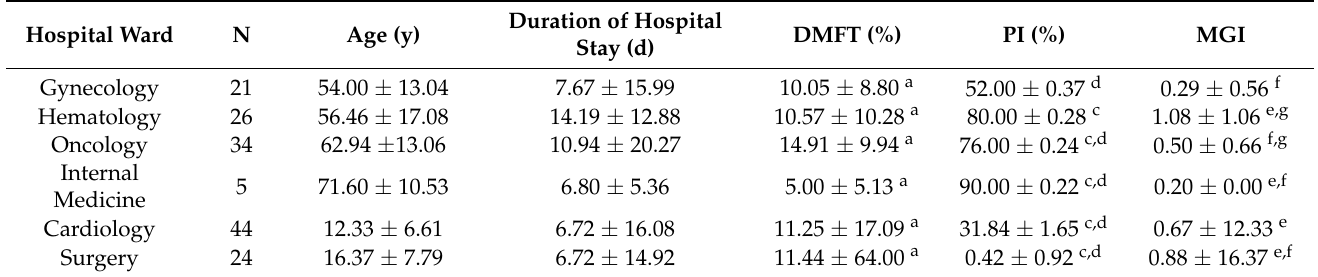
Table 1. Descriptive statistics (mean ± standard deviation) of hospitalized patients for each hospi- tal ward.